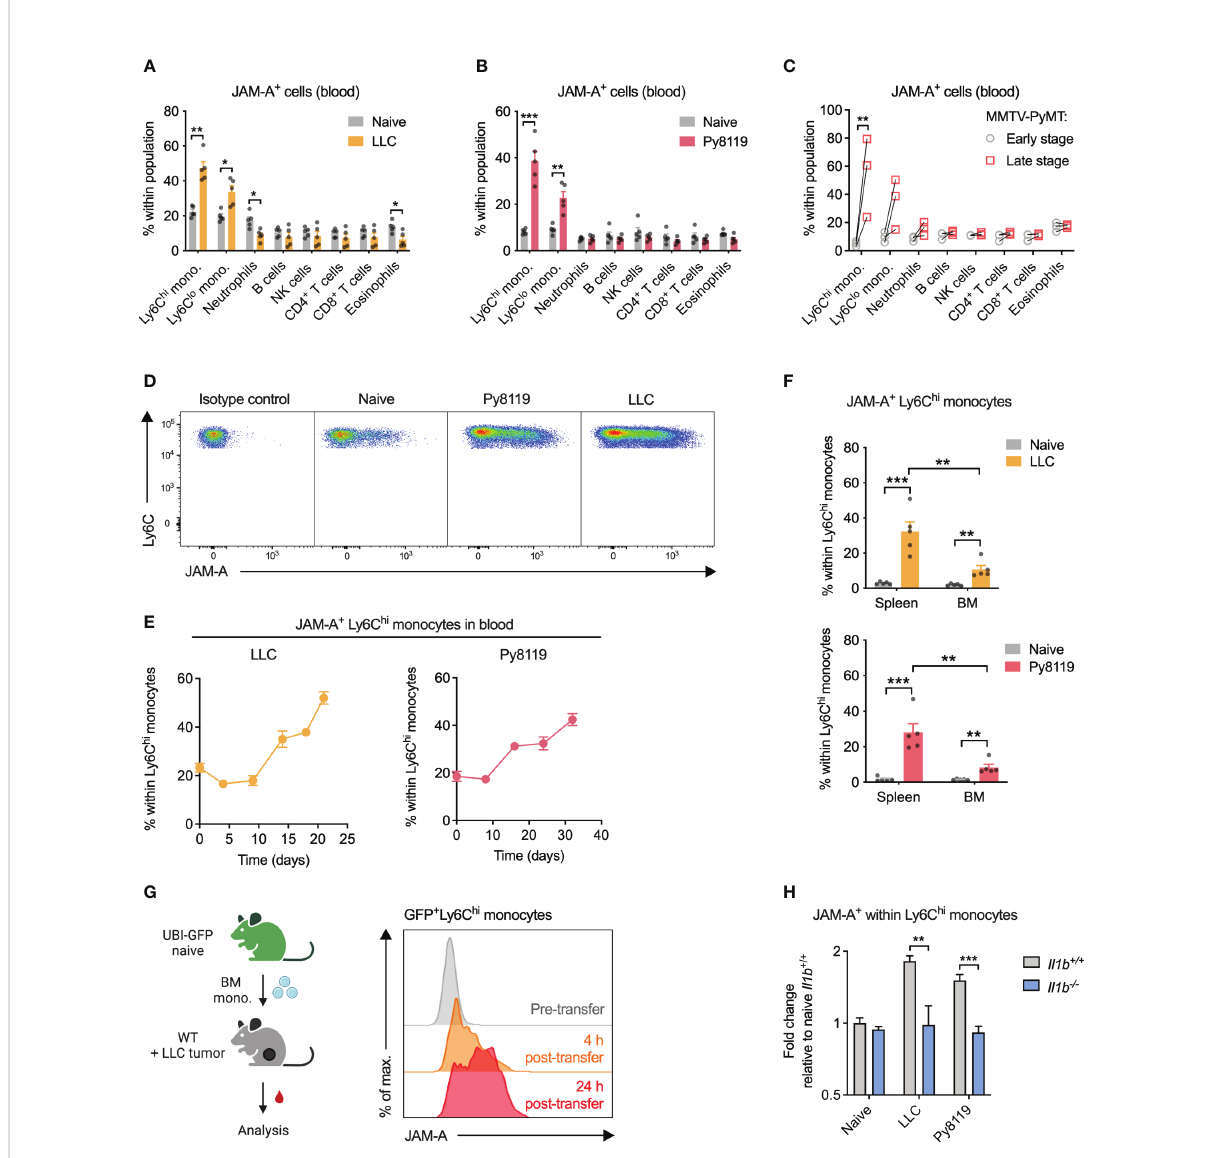
FIGURE 1 Cancer-associated in fl ammation promotes upregulation of JAM-A on peripheral monocytes in an IL-1 b -dependent manner. (A) Frequency of JAM-A + cells within the most abundant immune cell populations in the blood of mice with sc. LLC tumors (21 days post-engraftment, 1678 ± 212mm 3 tumor volume). (B) Same as (A) in orthothopic Py8119 breast tumors (32 days post-engraftment, 1199 ± 114mm 3 tumor volume). (C) Frequency of JAM-A + cells within the most abundant immune cell populations in the blood of MMTV-PyMT mice at early stage (no palpable tumor) and late stage (tumor volume reached 1500 mm 3 ) of tumor progression. Dots connected with line denote values from the same animal. (D) Representative fl ow cytometry dot plots of JAM-A expression in Ly6C hi monocytes from the blood. (E) Changes in the frequency of JAM-A + cells within Ly6C hi monocytes during tumor progression in the blood of mice with orthotopic Py8119 tumors or sc. LLC tumors (corresponding tumor volumes are shown in Supplementary Figure 2). (F) Frequency of JAM-A + cells within Ly6C hi monocytes in the spleen and bone marrow (BM) of mice with orthotopic Py8119 tumors or sc. LLC tumors (time post-engraftment and tumor volume as in panels A and B ). (G) JAM-A expression on GFP + Ly6C hi bone marrow-derived monocytes adoptively transferred into LLC tumor-bearing mice on day 18 of tumor development. (H) Fold change of JAM-A + cells within Ly6C hi monocytes in the blood of Il1b +/+ or Il1b -/- mice with sc. LLC tumors (day 19 post-engraftment) or orthotopic Py8119 tumors (day 35 post-engraftment) compared to naive Il1b +/+ mice (tumor burden is shown in Supplementary Figure 3). Cell type frequencies were determined using fl ow cytometry. Graphs show mean and SEM. Panel (C) paired two-tailed t-test; All other panels: unpaired two-tailed t-test; *P < 0.05, **P < 0.01, ***P <